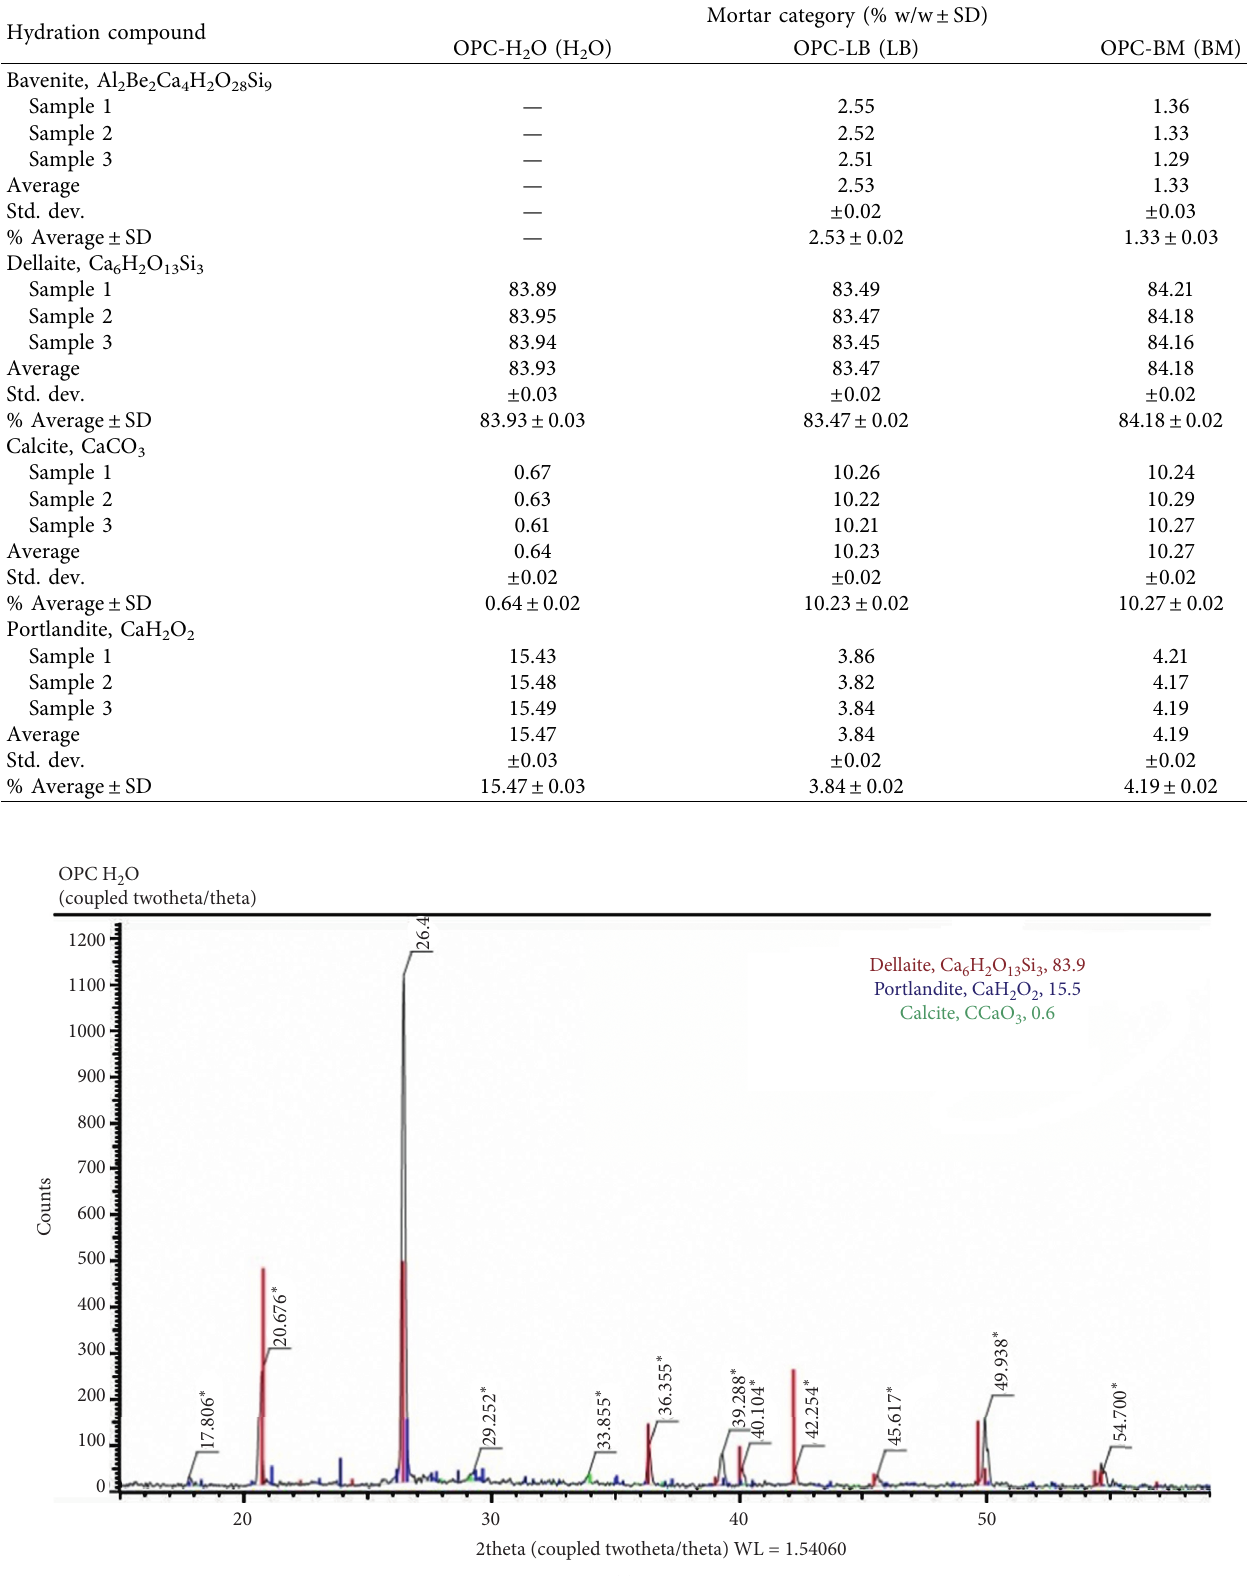
Table 2: XRD (% w/w ± SD values) summary for hydrated OPC microbial mortars prepared and cured in respective bacteria against control OPC mortar after 28 th day of